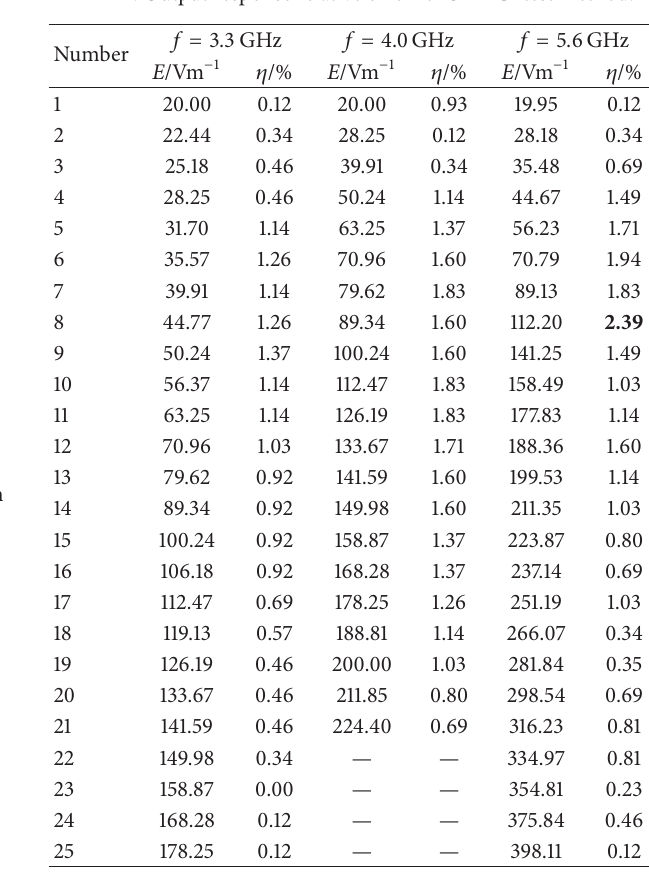
Table 1: Output response relative error for SDMCI test